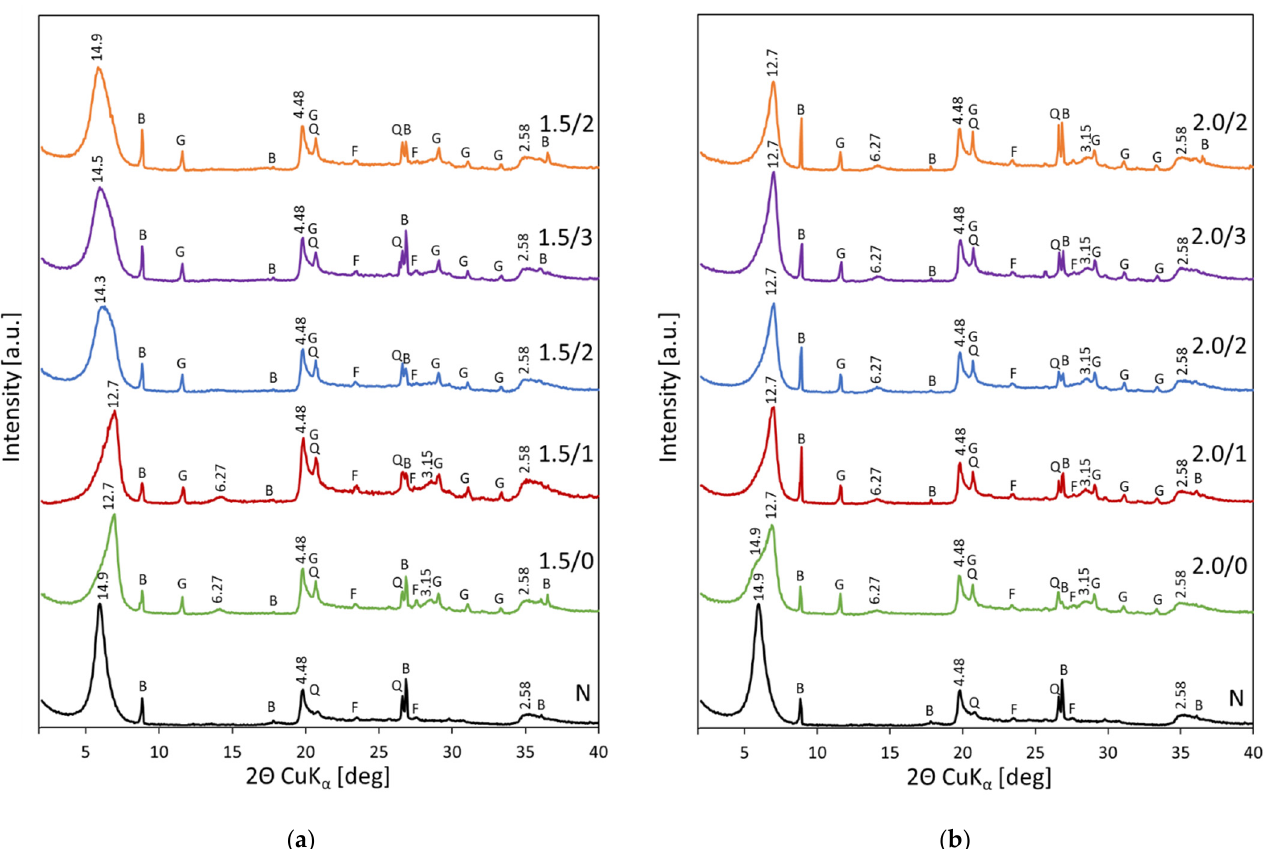
Figure 1. Powder XRD patterns of bentonite activated with H 2 SO 4 in quantities corresponding to: ( a ) 1.5 × CEC; ( b ) 2.0 × CEC; G—gypsum, B—biotite, Q—quartz, F—feldspar.